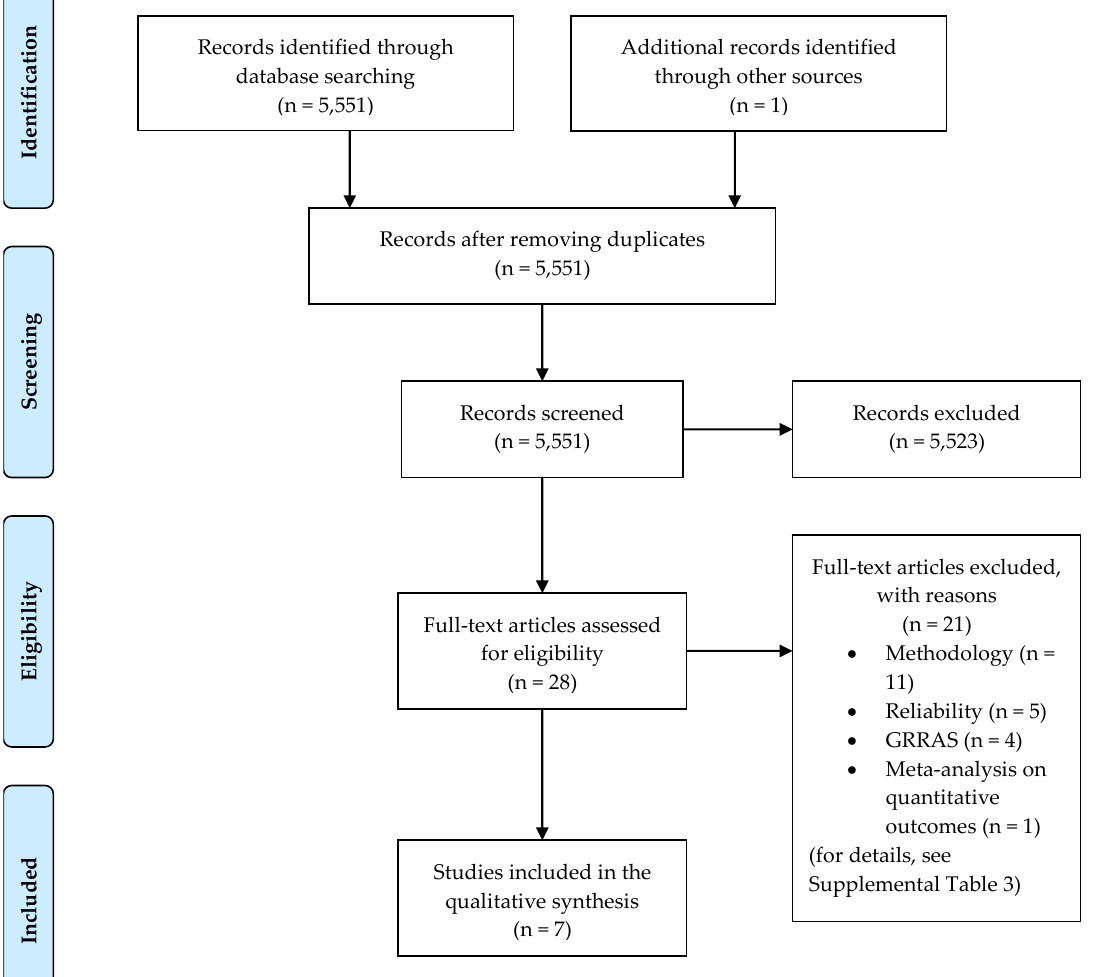
Figure 1. Preferred Reporting Items for Systematic Reviews and Meta-Analysis (PRISMA) flow diagram. GRRAS: Guidelines for Reporting Reliability and Agreement Studies [19].